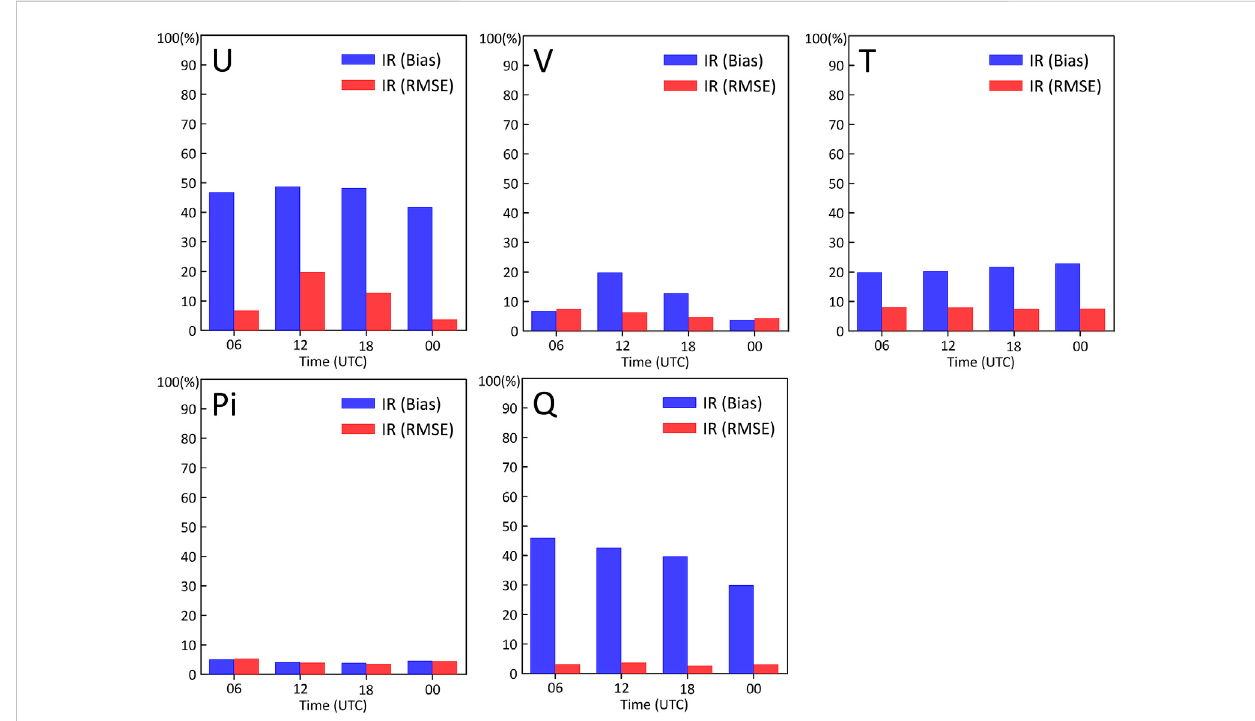
The improvement rate for the BC and CTL experiments at different times (blue bars indicate the improvement rate of the bias, and red bars indicate the improvement rate of the